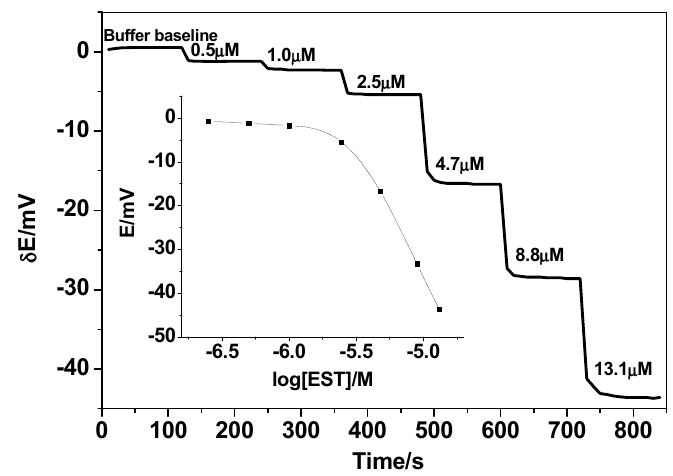
Figure 4. The dynamic potentiometric responses of 17 β -estradiol (EST)-based sensor in 50 mM HCO 3 − /CO 32 − buffer solution, pH 10.5. The inset shows the measuring calibration plot for EST.